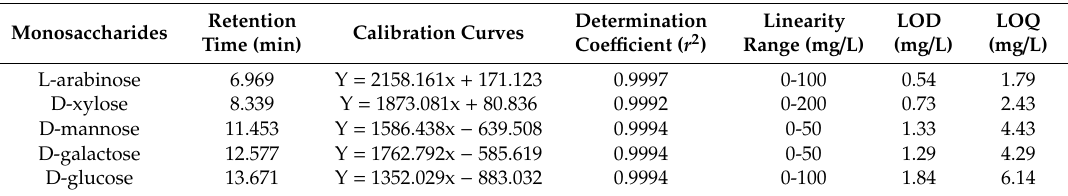
Table 1. Calibration curves of standard